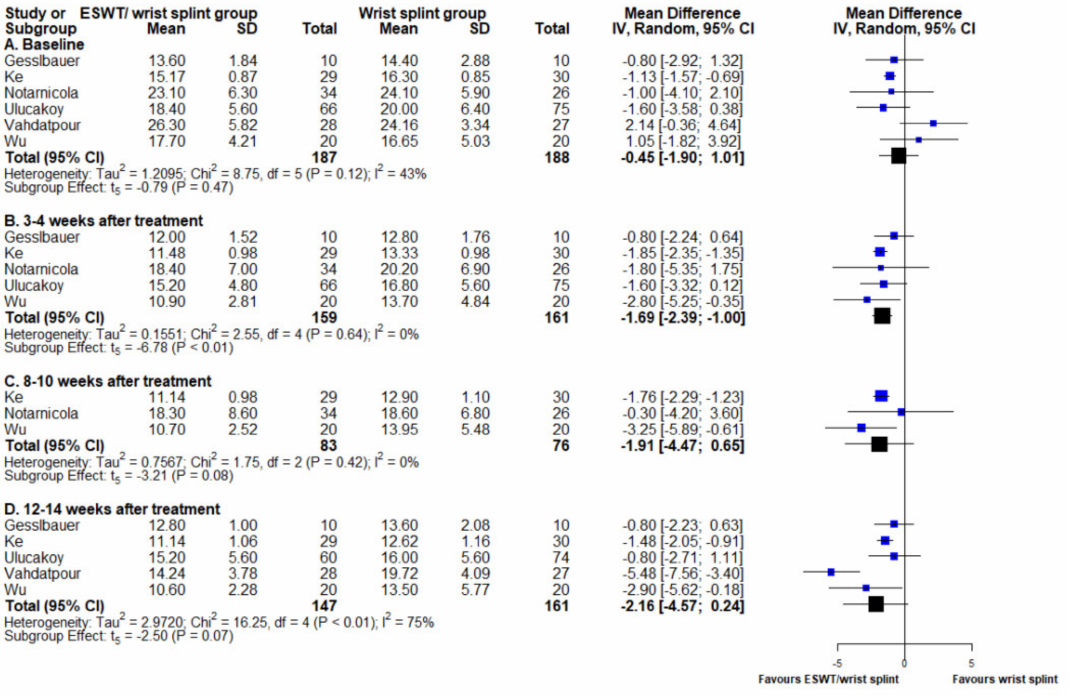
Figure 2. Forest plot of mean difference in BCTQf score between ESWT/night wrist splint and night wrist splint alone groups. Mean difference and standard deviation of each enrolled study and the meta-analysis results were presented as blue and black squares at the left column of the figure, respectively. BCTQf score at (A) baseline, (B) four weeks after intervention, (C) 8–10 weeks after intervention, and (D) 12–14 weeks after